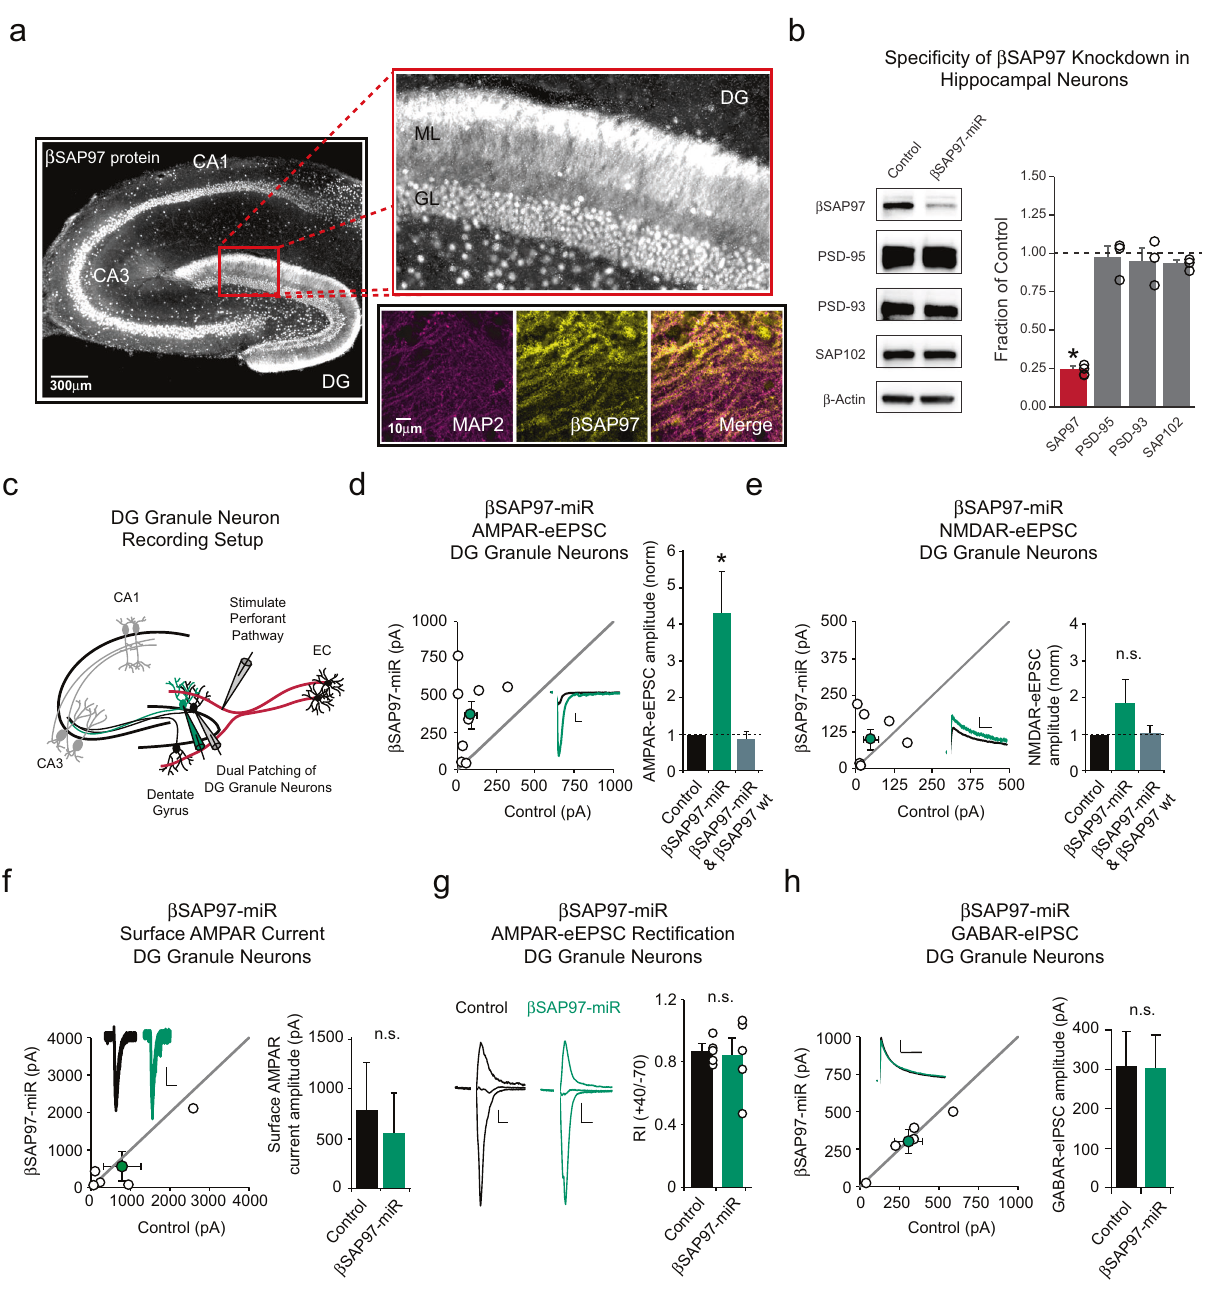
paired control neurons (Fig. 1d), a surprising phenotype given